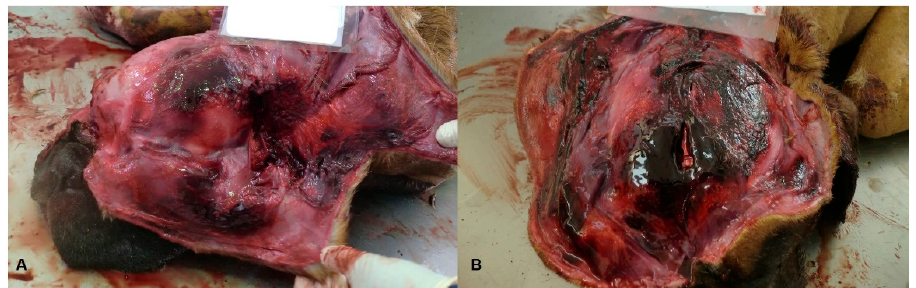
Figure 2. ( A , B ): Traumatic brain injury of blunt nature in two senior, large sized, male Boxer dogs belonging to the same owner. Traumatic brain injuries, compatible with action of a blunt object which caused compression fractures of the head, with extensive hemorrhagic lesions and neuroparenchyma tear at the level of the brainstem.